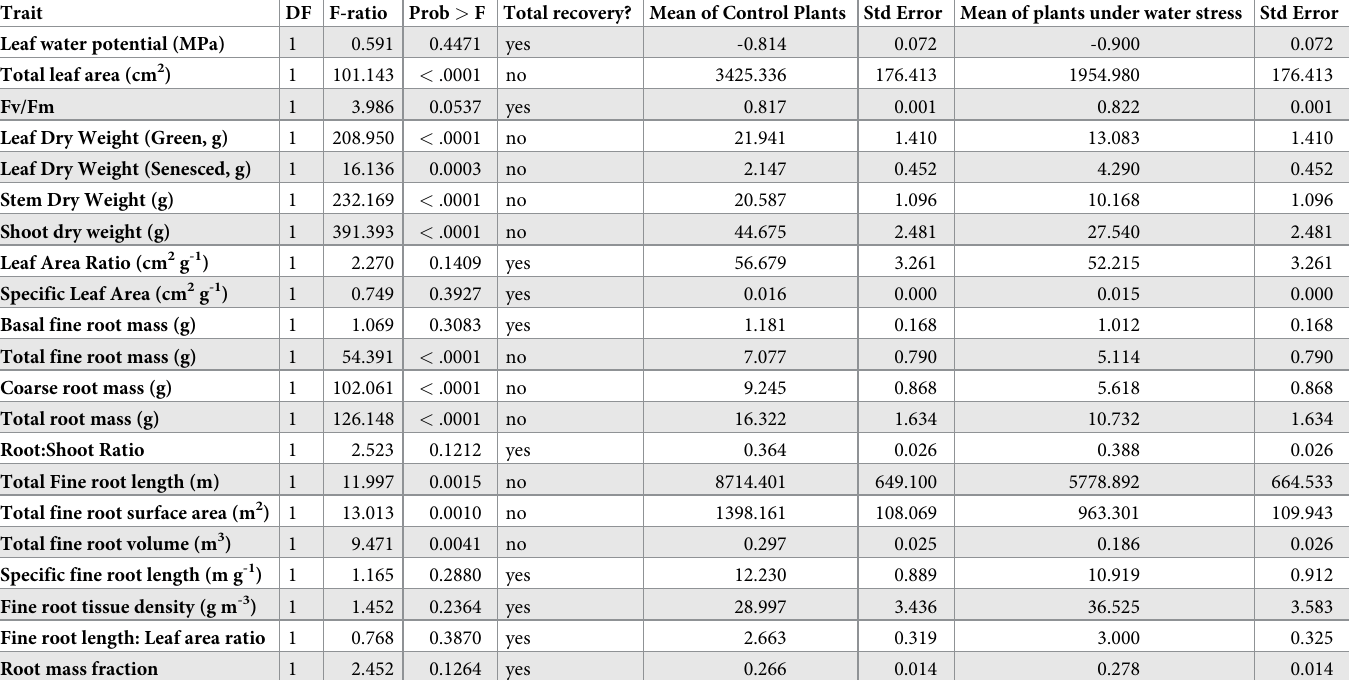
Table 3. Standard least squares analysis of physiological traits with variety as a random effect (REML method) after recovery phase.